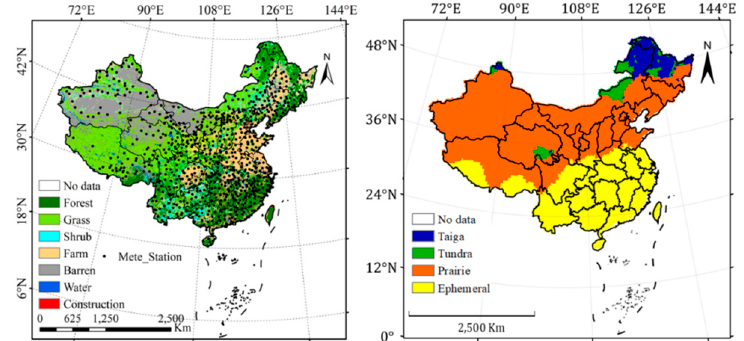
Figure 1. Spatial distribution of land cover and weather stations ( left ) and climatological snow classes ( right ) in China. Black points are sites. The base map on the left shows the land cover types. The right figure shows that there are mainly four snow classes based on snow classification system in Sturm et al.